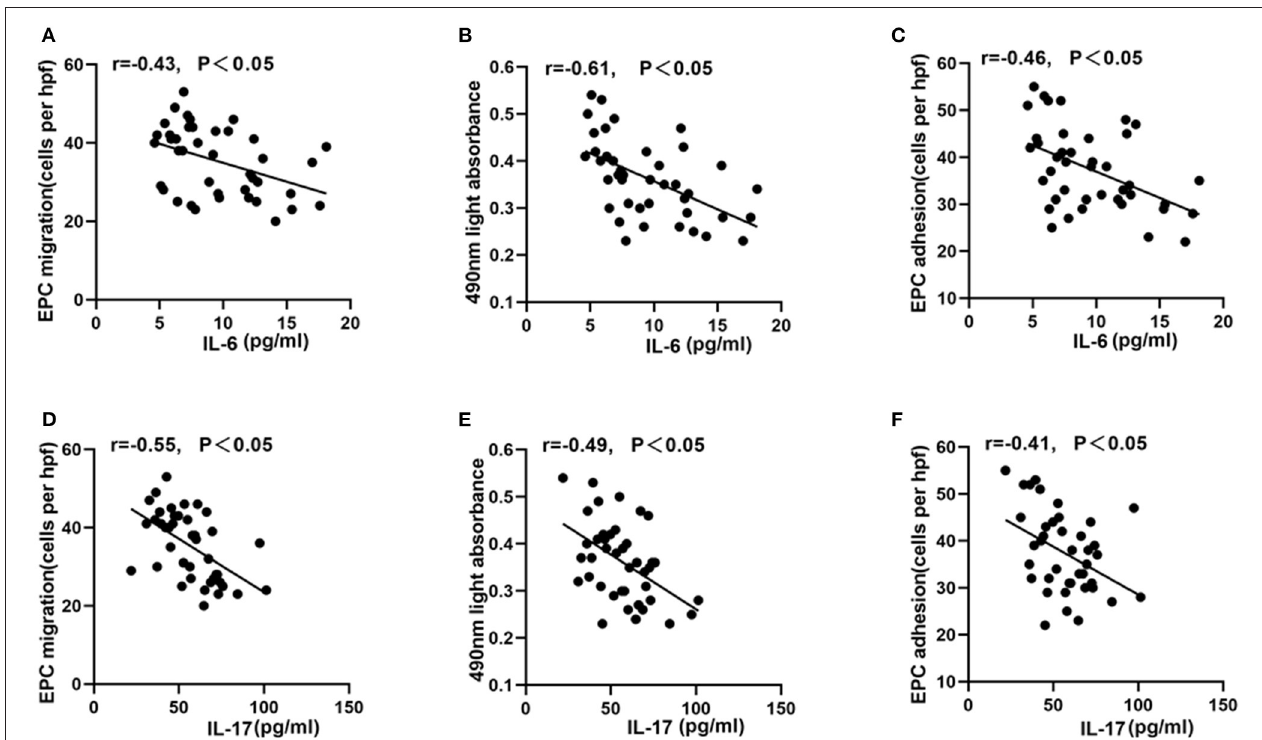
FIGURE 4 | Correlation between EPC function and IL-6 or IL-17. IL-6 (A–C) and IL-17 (D–F) were negatively correlated with EPC migration, proliferation, and adhesion.